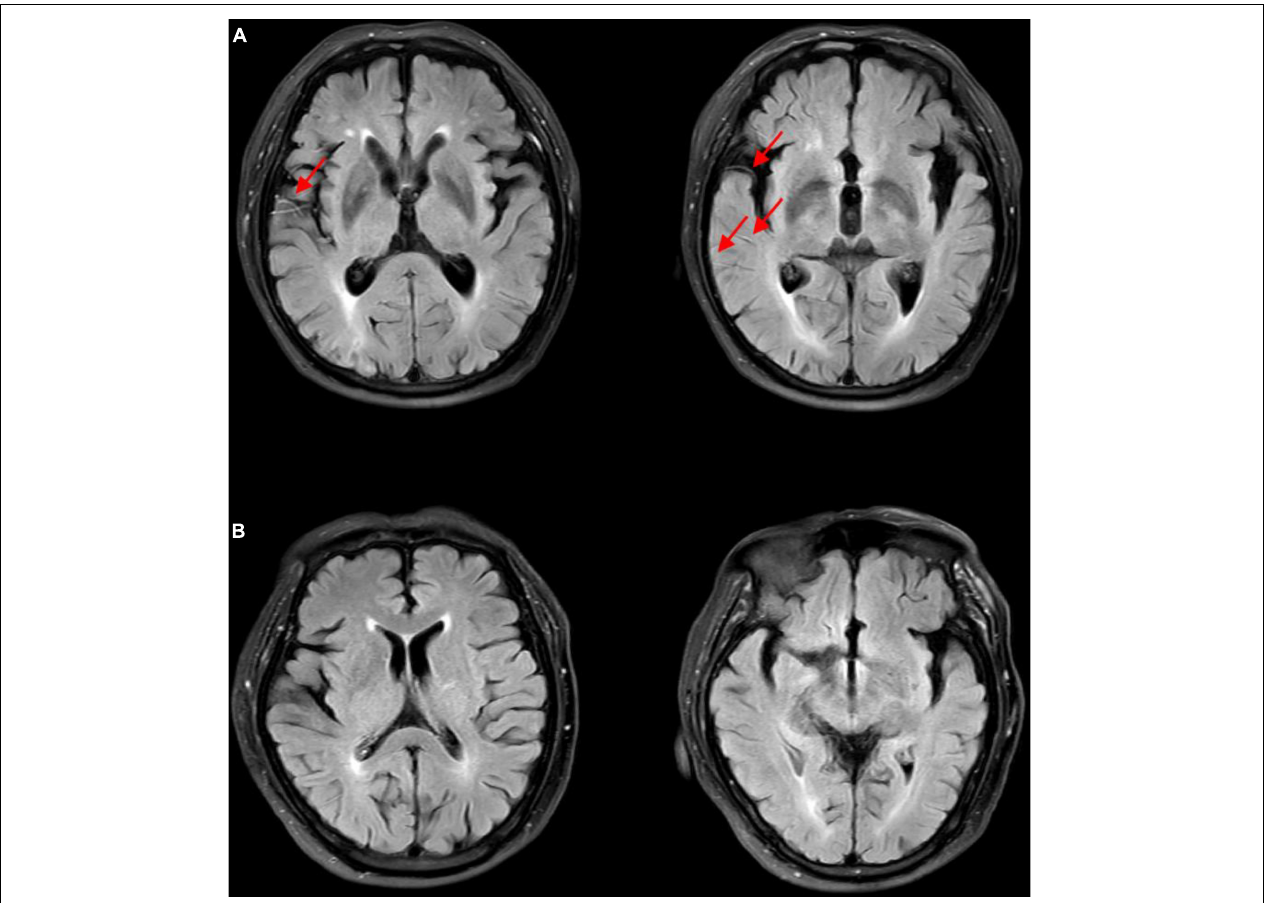
FIGURE 2 | FLAIR images of representative “high” and “low” FVH scores in acute stroke patients. (A) High FVH scores (FVH = 6). Red arrows show FVHs. (B) Low FVH scores (FVH = 0). FVH, fluid-attenuated inversion recovery vascular